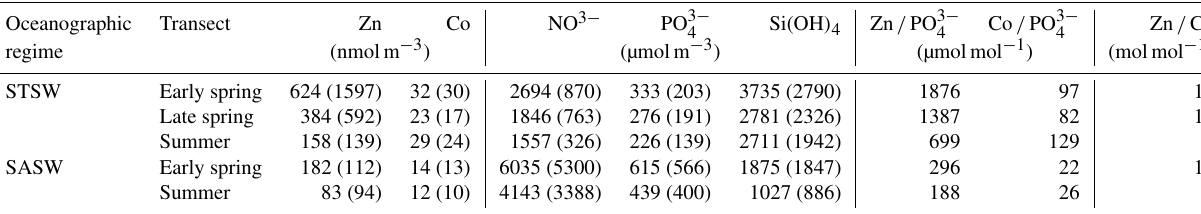
Table 2. South-eastern Atlantic dissolved micro- and macronutrient mean concentration inventories for the upper water column during early- spring (D357-1), late-spring (D357-2) and summer (JC068) transects. STSW and SASW waters were defined using the θ 15 ◦ C isotherm (Sect. 3.4) and are compared with total inventories calculated for the shallower mixed layer (in parentheses) that include continental inputs of dissolved Zn and Co. Zn / PO 3 − , Co / PO 3 − and Zn / Co represent the concentration inventory ratios for STSW and SASW, respectively. 4 4 STSW: sub-tropical surface water; SASW: sub-Antarctic surface